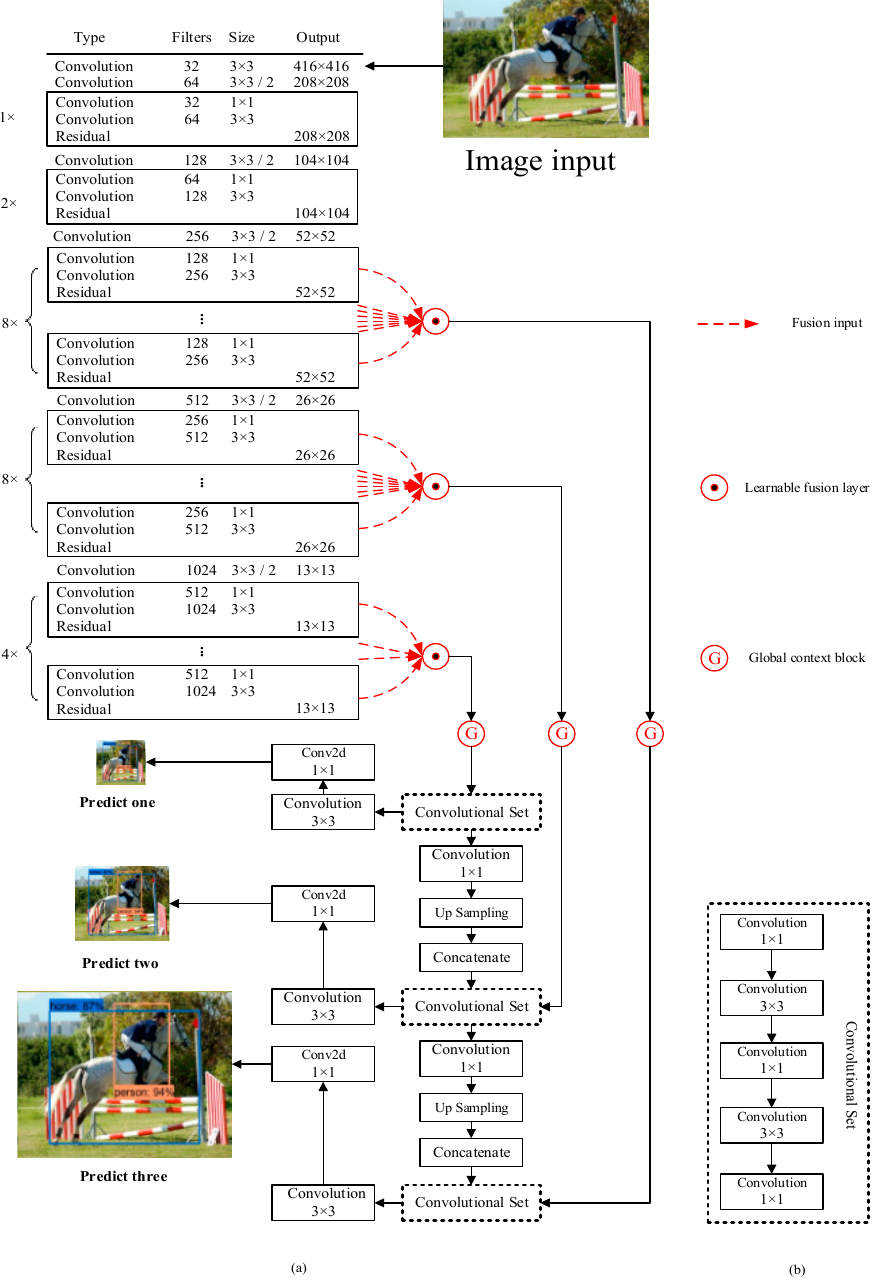
Figure 1. The structure of GC-YOLOv3. ( a ) The main framework of GC-YOLOv3. ( b ) Convolutional set.